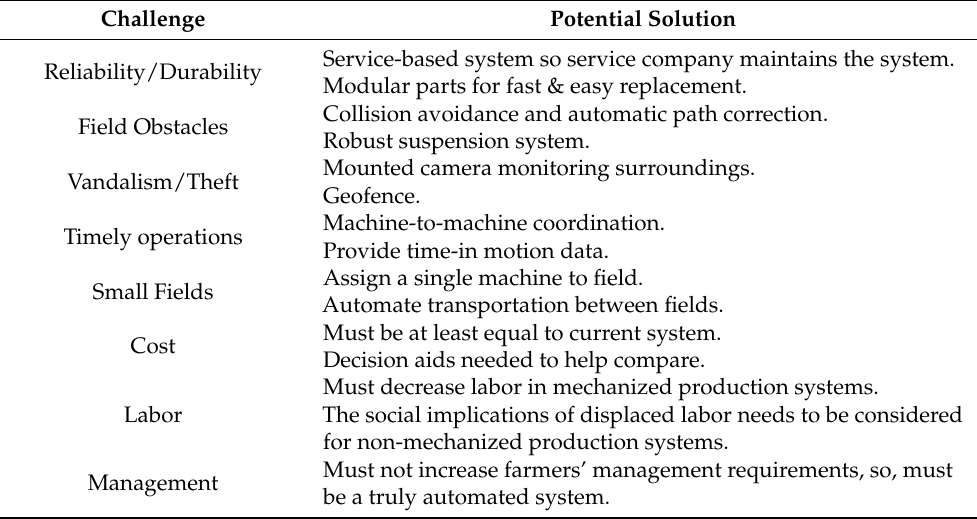
Table 1. Summary of potential challenges to increasing the automation of cotton production